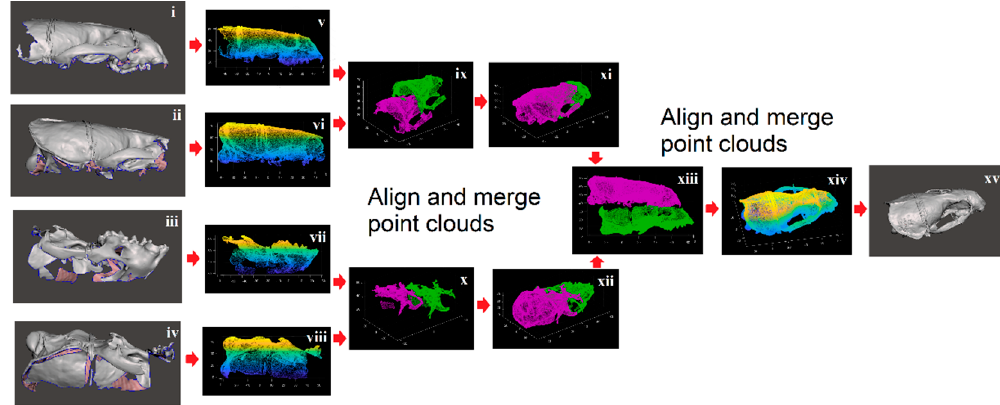
Figure 1. Stitching process of partial scans: point clouds extracted from shape files from partial three- dimensional (3D) scans of the crania on the left-hand side of the figure are aligned and merged (as shown) in order to form a complete surface shape file shown on the right-hand side of the figure. Four partial scans of the crania as shown ( i to iv ) were found for each otter. The original shape files (STL format) were used to generate point clouds ( v to viii ). The front and rear of the top and bottom sections were aligned ( ix , x ) and combined ( xi , xii ) by using the “point cloud register” command in MATLAB R2019b, and the resulting top and bottom sections were aligned and combined ( xiii ) to create a complete representation of the surface shape as a point cloud ( xiv ). MESHLAB V2016.12 (www.meshlab.net) was then used to create the final shape file (in STL format) from this point cloud ( xv ).